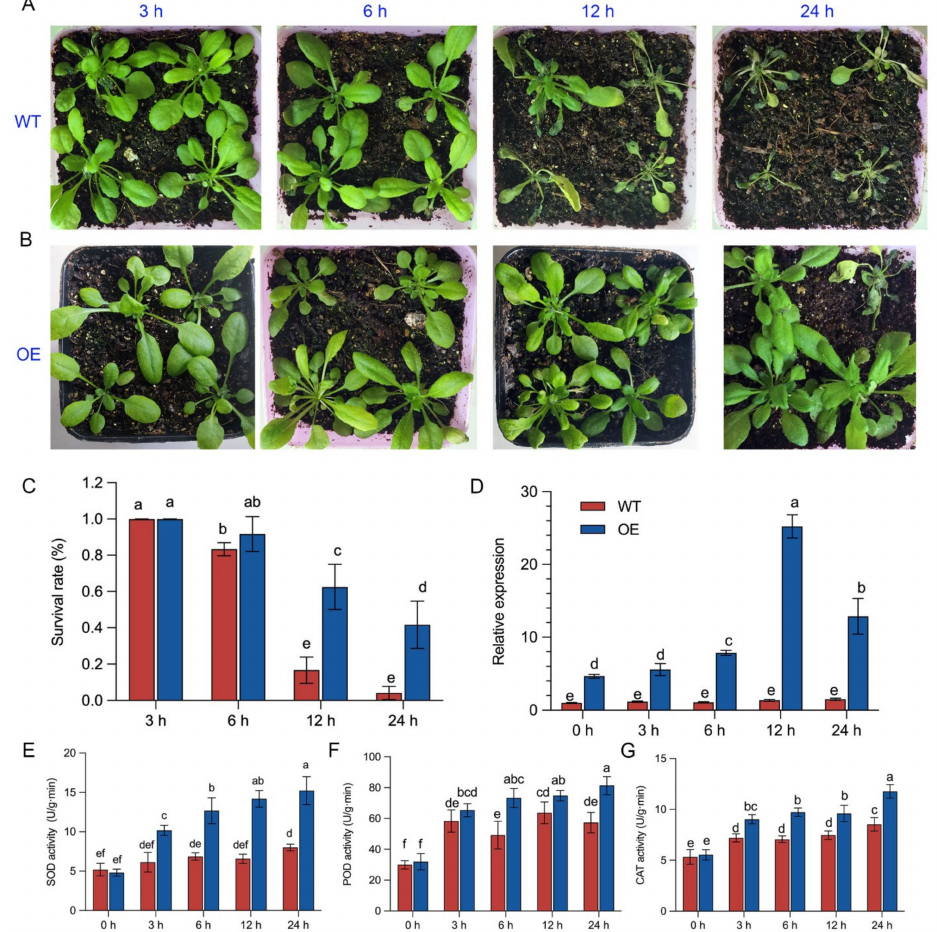
Figure 7. Phenotype, expression, and physiological activity of BrZAT12 transgenic Arabidopsis after low-temperature treatment. ( A , B ) Phenotype of BrZAT12 transgenic Arabidopsis after low-temperature treatment. ( C ) Survival rate of Arabidopsis plants after low-temperature treatment. ( D ) Quantitative RT-PCR test of BrZAT12 transgenic Arabidopsis at low temperature. ( E – G ) SOD, POD, and CAT activities, respectively. WT: wild-type Arabidopsis , OE: BrZAT12 transgenic Arabidopsis . a–f represent significant differences between treatments at p ≤